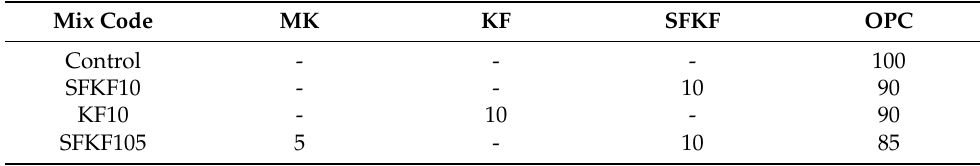
Table 2. Composite constituent